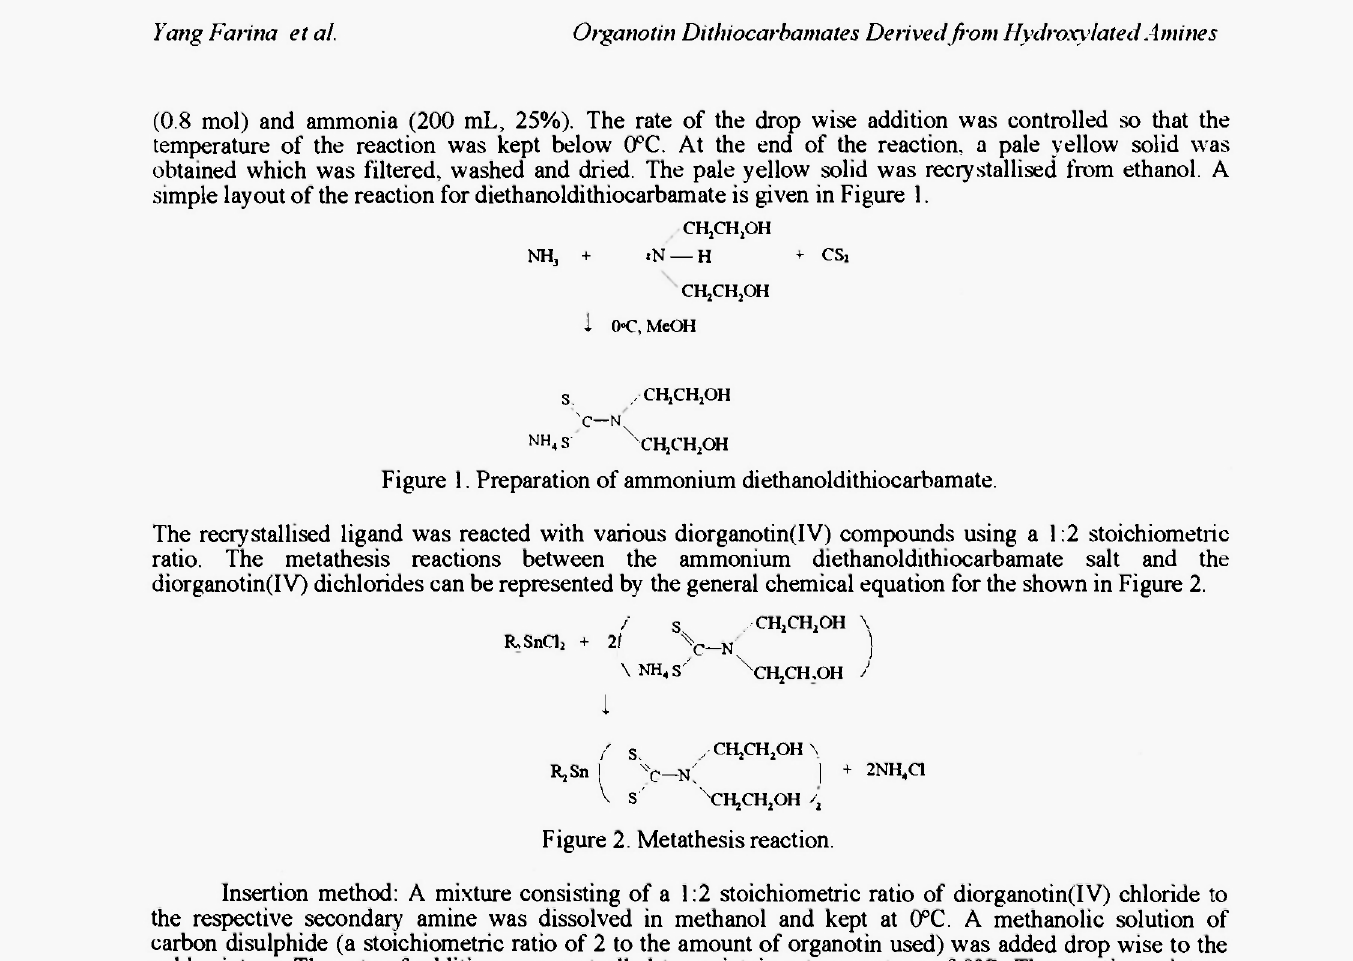
Figure 3. Insertion reaction involving